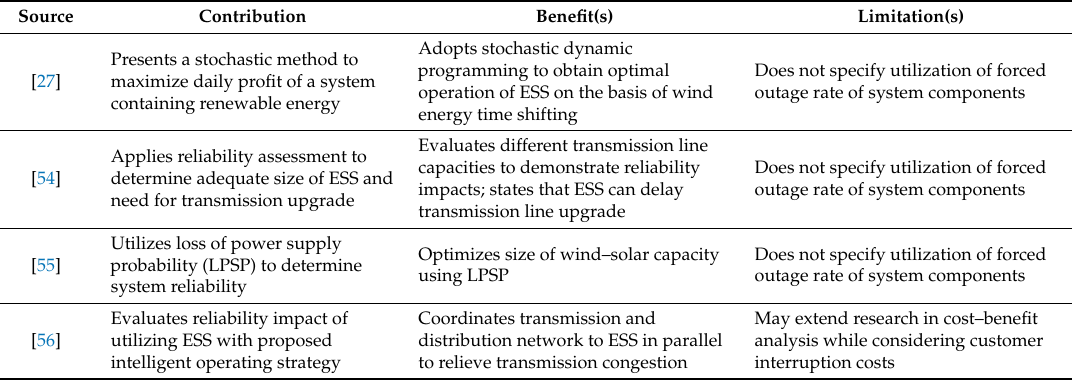
Table 7. Comparison of notable works on impacts of ESS on